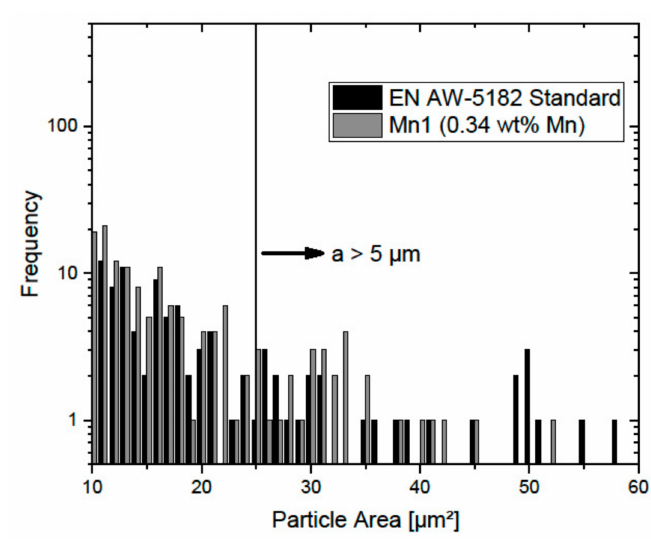
Figure 10. Histogram of particles with more than 10 µ m 2 area for standard EN AW-5182 (0.41% Mn) and the Mn1 modification; note the relatively high fraction of constituents larger than 25 µ m 2 ( a > 5 µ